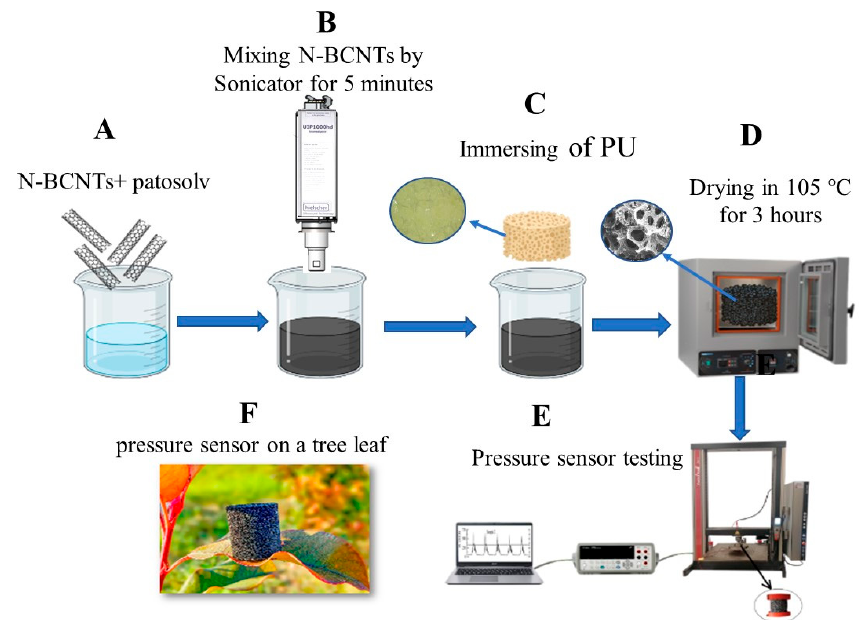
Table 1. N-BCNT and PU weight of the prepared N-BCNT/PU nanocomposite.